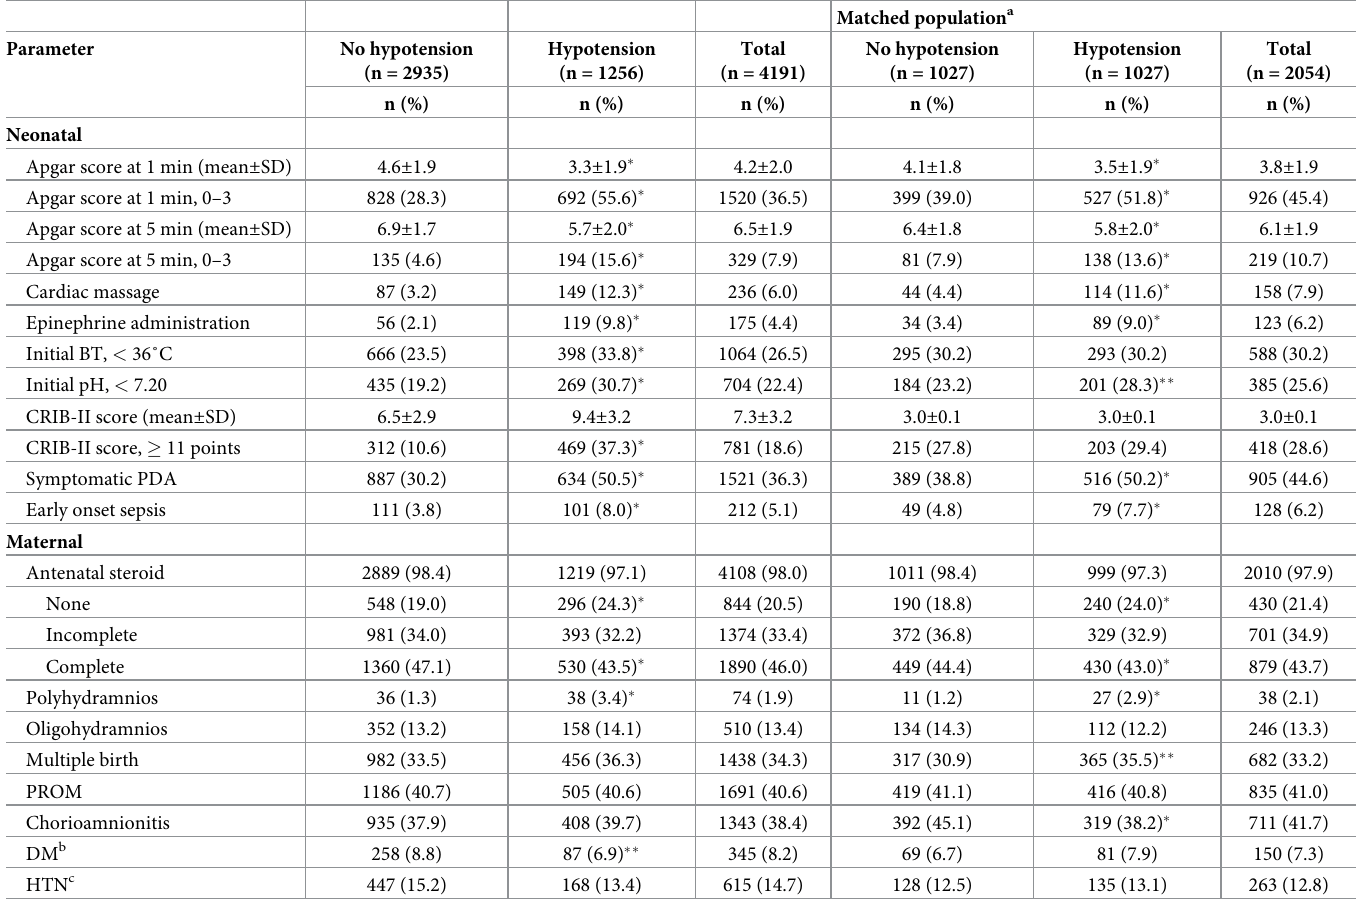
Table 2. Risk factors of treated hypotension in VLBW infants during the first postnatal